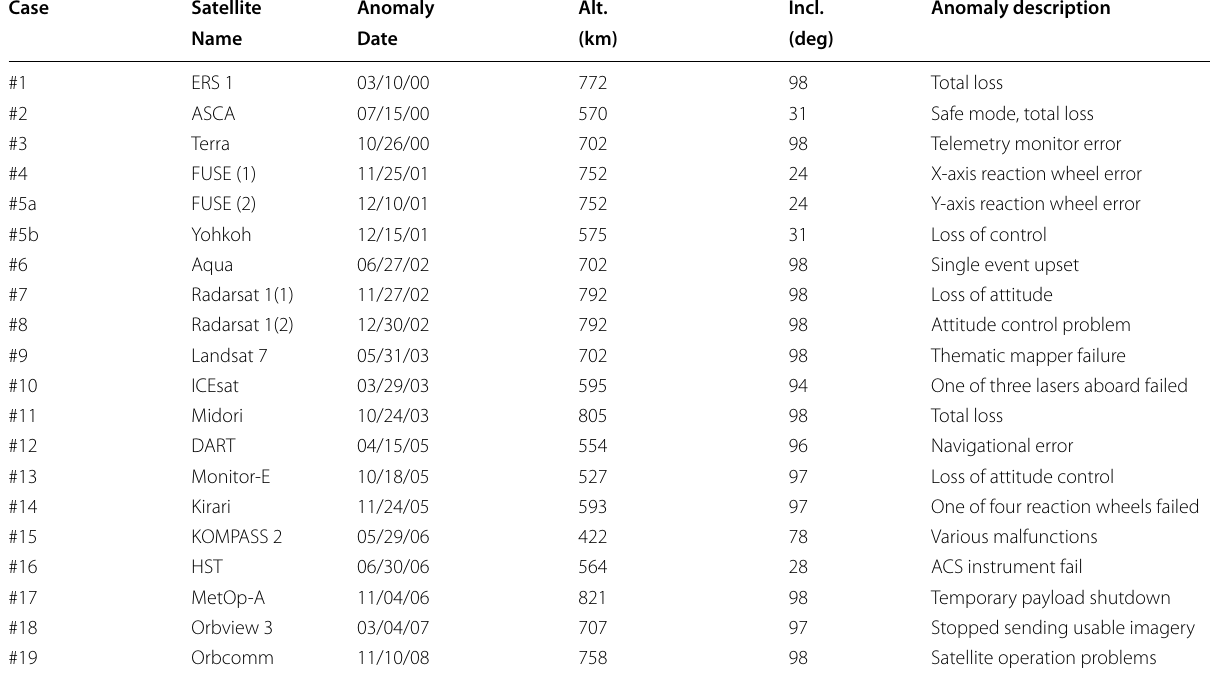
Table 4 LEO satellite anomalies during the period 2000–2008 including brief description of